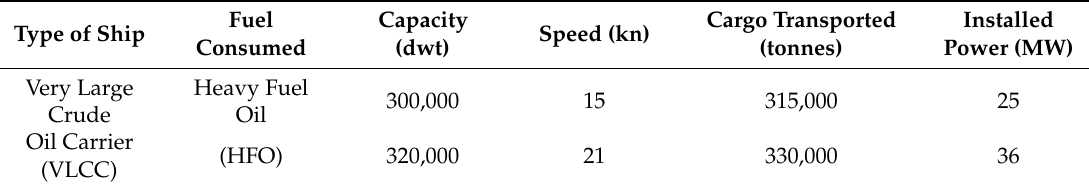
Table 1. Operational parameters for simulation.